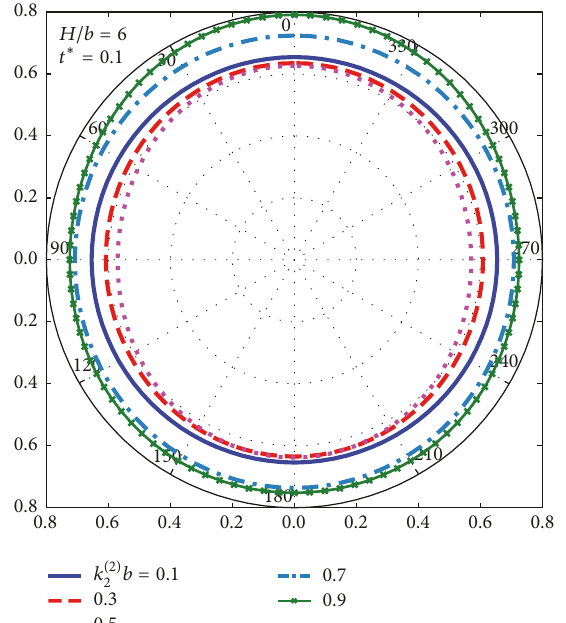
Figure 4: Radial stress (𝜎 ∗ 𝑟𝑟 ) versus polar angle at 𝑟 = 𝑏 for different wave numbers (𝑘 (2) 2 𝑏) for a tunnel in hard soil.